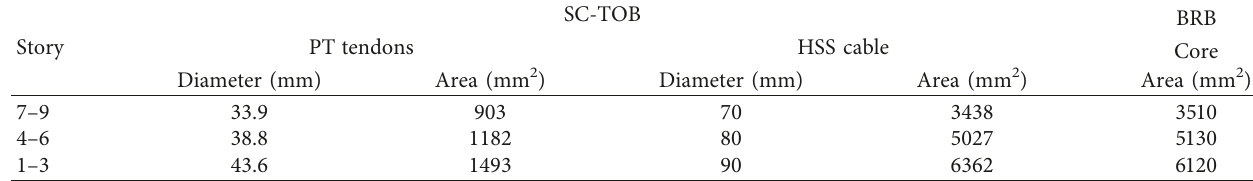
Table 5: Geometric detail of braces of the 9-story frames.